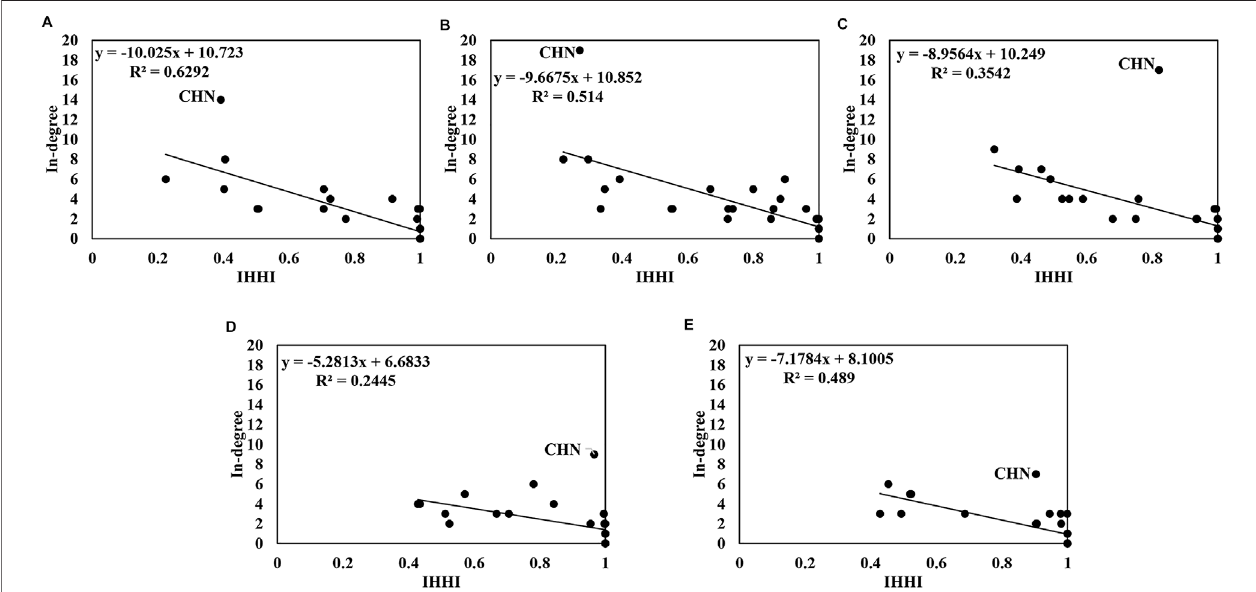
FIGURE 6 | The scatter plot between the number of import partners and the IHHI ( (A – E) correspond to the years of 2000, 2005, 2010, 2015, and 2019 respectively).